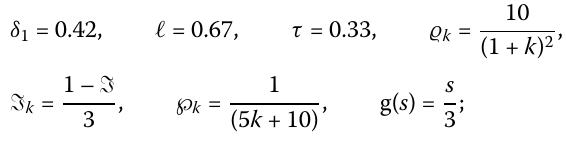
(4) Algorithm 1 (briefly, M-EGM